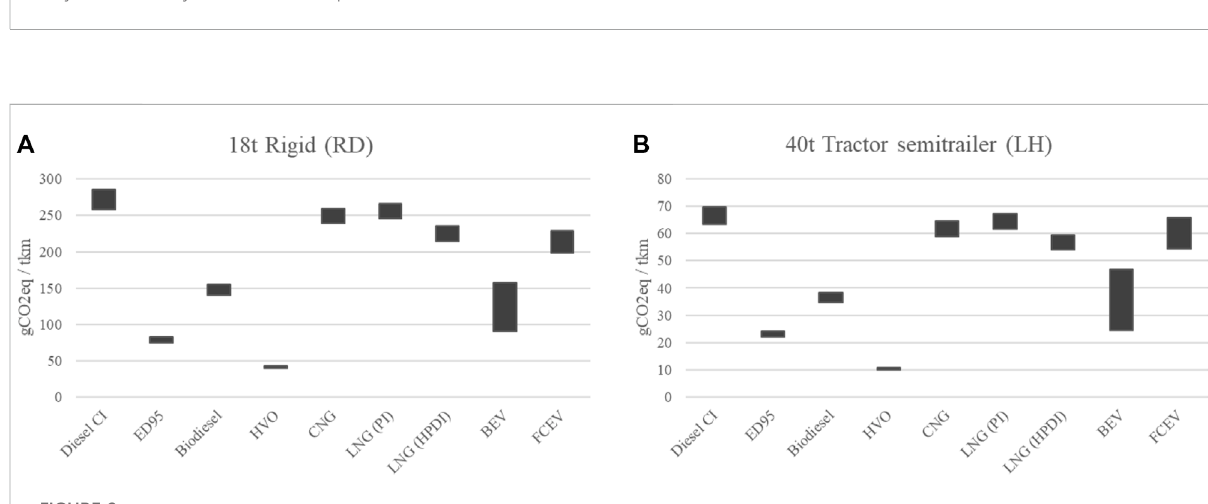
FIGURE 2 HCV powertrain-speci fi cWTW GHG emissions:Group 4 (A) and Group 5 (B) . Note: the top of the bar re fl ects 2016 values while thebottom the 2025+ values (see the methodology in the original source, including assumptions and additional results). CI, compression ignition; ED95, ethanol diesel (95%); PI, positive ignition; HPDI, high pressure direct injection. Source: adapted from Prussi et al.